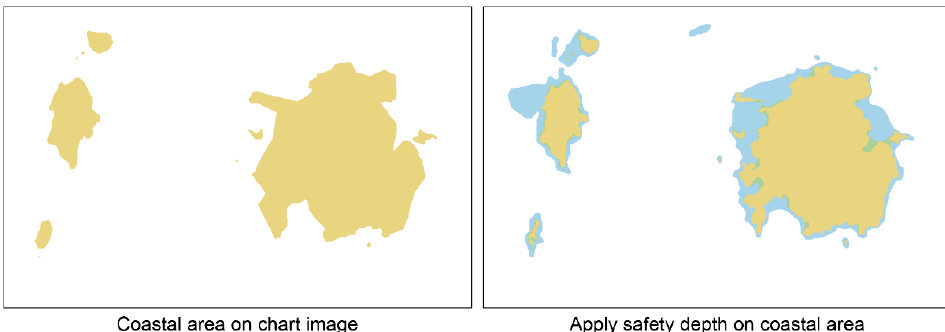
Figure 7. Electric chart image with safety depth.